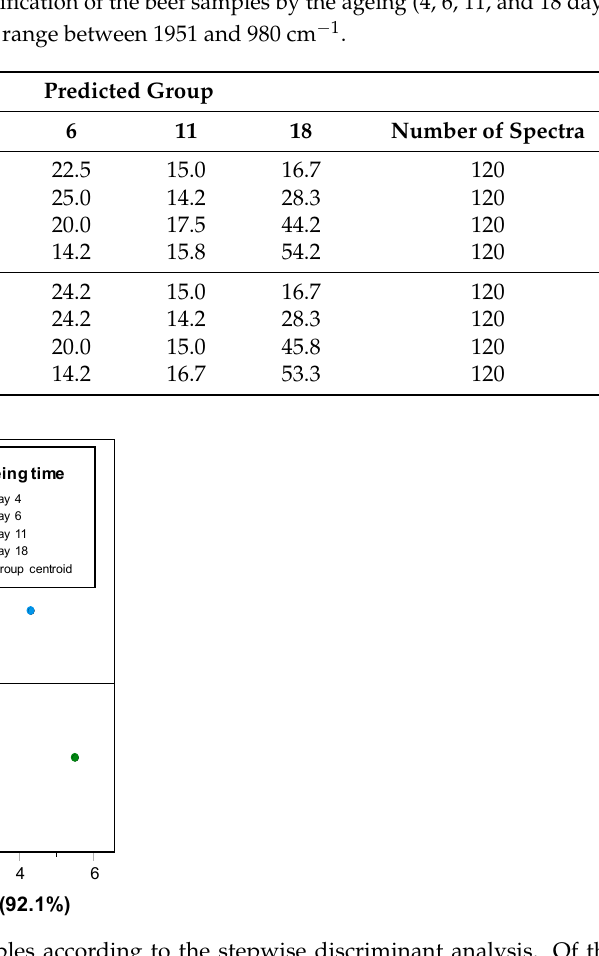
Table 4. Results of the classification of the beef samples in the initial and final ageing days (4 and 18 days) using the spectral information in the range between 1951 and 980 cm − 1 .